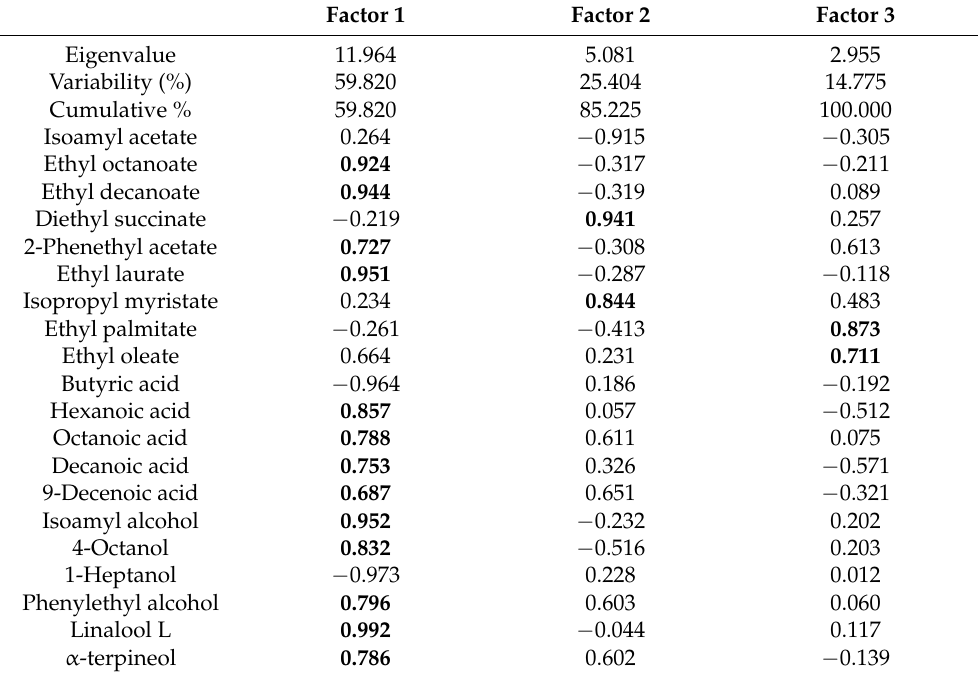
Table 4. Factor loadings of the experimental samples.